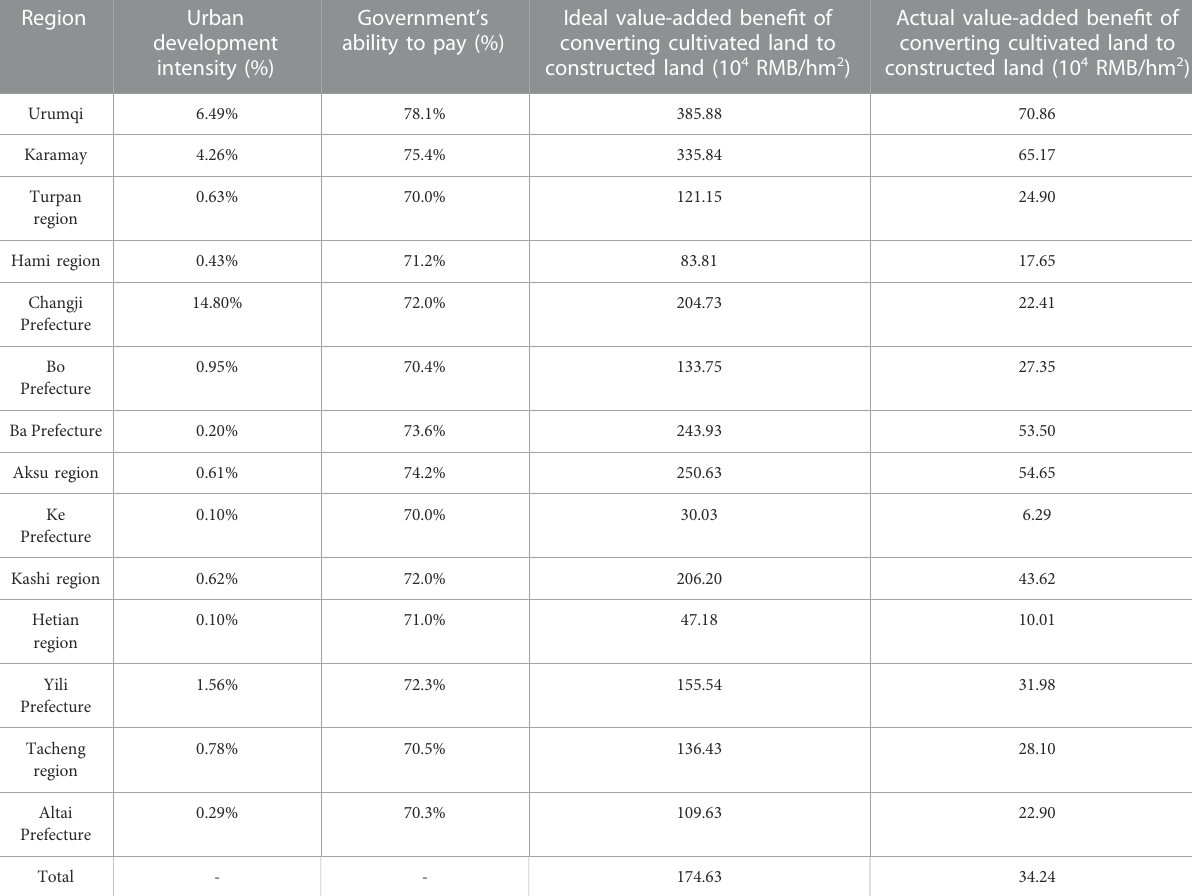
TABLE 6 Correction factors for cultivated land compensation and measurement of actual value-added bene fi ts in the state (city).